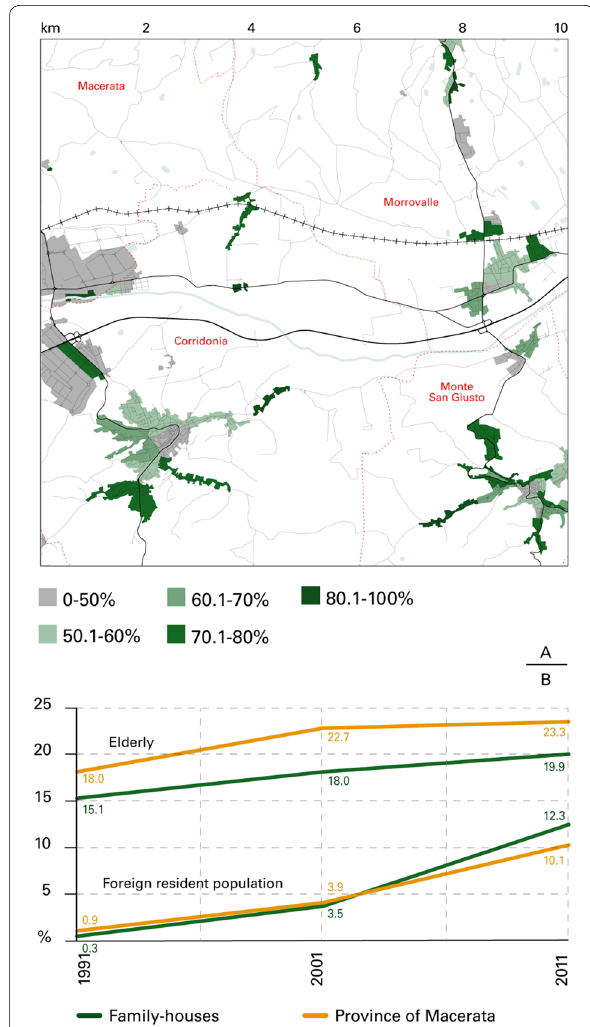
Fig. 10 a Marche, valley of the river Chienti, 10 10 km sample. × Percentage of one- and two-interior buildings built in the period 1961–1991 out of the total residential stock at 2011 (authors’ calculations on data from Istat census). b Marche, valley of river Chienti: trends in the elderly and foreign population within the census blocks where family houses constitute more than 50% of the housing stock (authors’ calculations on data from Istat